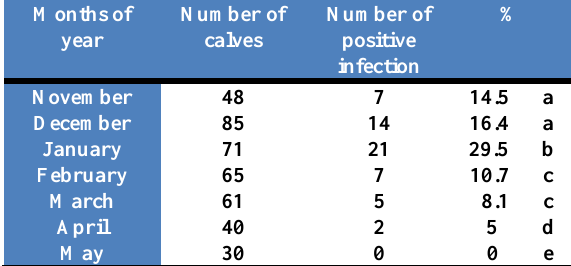
Table, 6: The effect of months of study on rota viral infection in examined